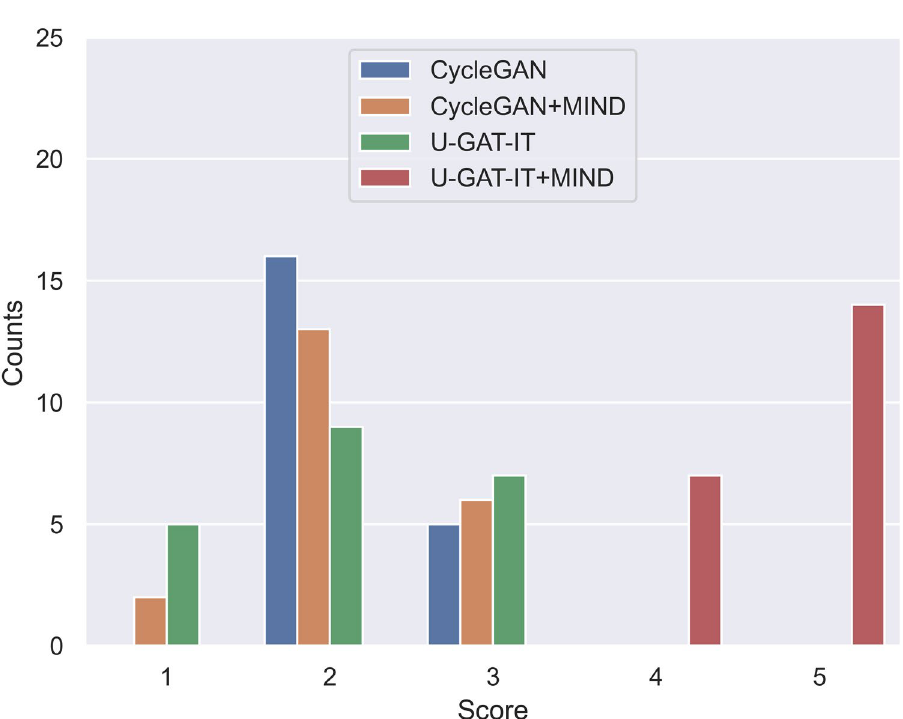
Figure 10. Distribution of evaluation scores for four groups by Dr.